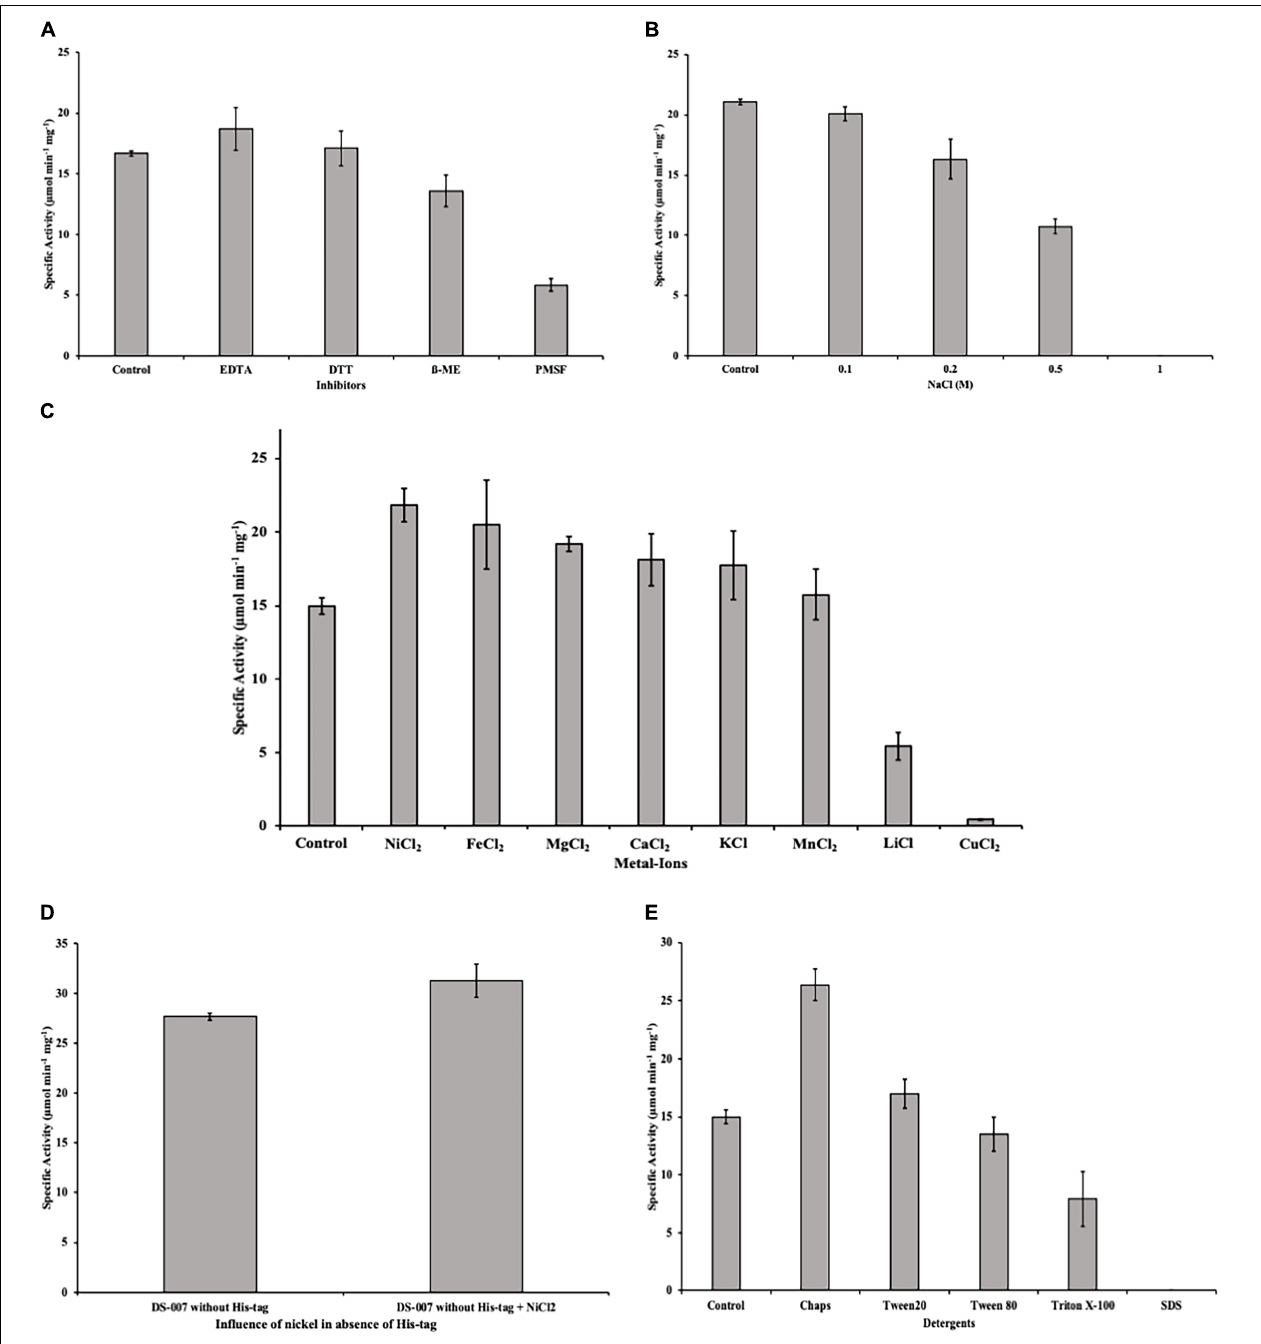
FIGURE 8 | (A) Inhibitors like EDTA and DTT at a concentration of 1 mM had no effect on the esterase activity of DS-007. Even PMSF only decreased the activity to 30%. (B) Incubating DS-007 with high concentrations of NaCl showed a significant decrease to 50% activity at 0.5 M NaCl. 1 M NaCl led to complete loss of activity. (C) Metal ions in a concentration of 1 mM increased the activity of DS-007 by up to 40% (Ni 2 + ). Only Li + and Cu 2 + reduced the activity to 35 and 3%, respectively. (D) The effect of Ni2+ is independent of the presence of the hexahistidine tag. Tag-less DS-007 was more active than DS-007 with hexahistidine tag in the absence of Ni 2 + and shows a comparable increase in activity when 1 mM Ni 2 + was added. (E) Detergents like Chaps and Tween 20 [1% (v/v)] increased the activity of DS-007, with Chaps increasing it 1.75-fold. SDS completely inhibited DS-007.